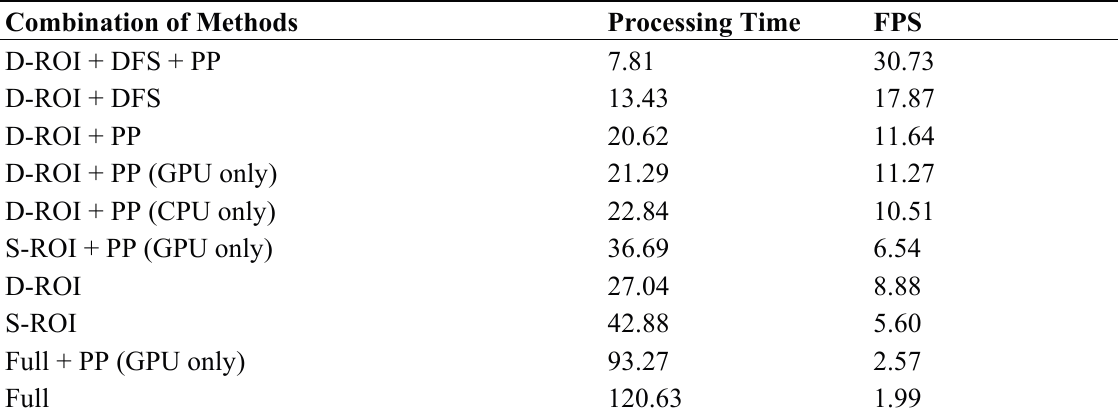
Figure 8. Evaluation of image processing in the vehicle environment using the proposed methods, D-ROI, DFS, and parallel processing (PP). ( a ) Pedestrian recognition; ( b ) license plate recognition, and comparisons of ( c ) computation load and ( d ) processing time for all four algorithms. (D-ROI frame n = 5). Table 6. Comparison of processing time for various combinations of proposed